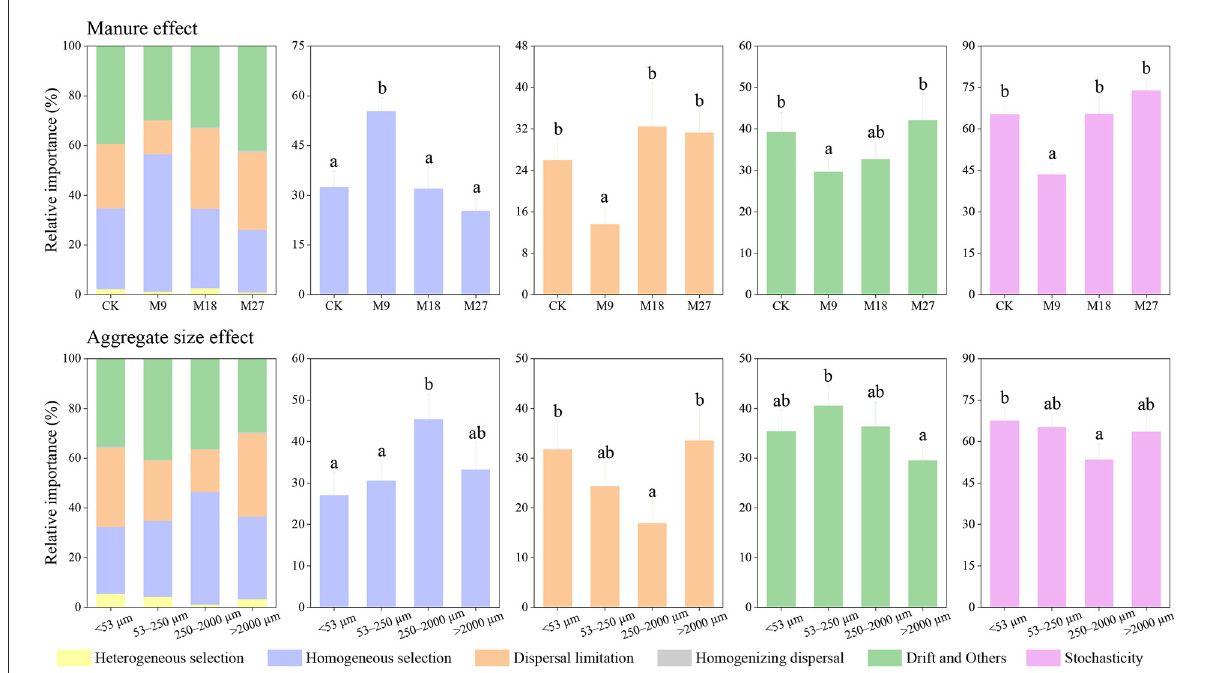
FIGURE7 Relative importance of different ecological processes in diazotrophic community assembly based on iCAMP. Different letters denote significant differences ( p < 0.05) based on bootstrapping with 1,000 replications. Stochasticity was estimated by the sum of dispersal limitation, homogenizing dispersal, and drift and